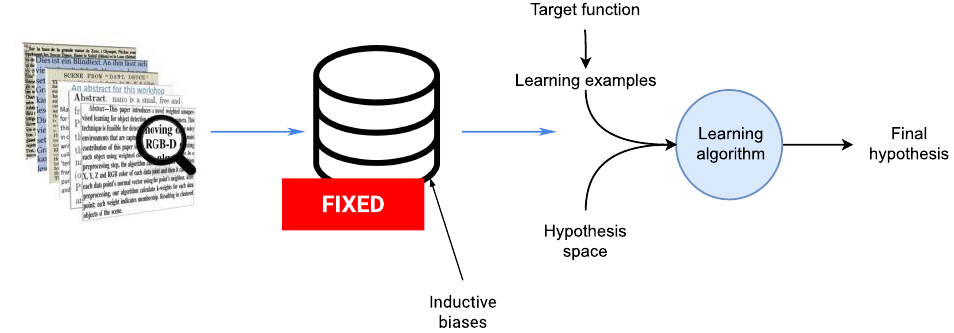
Figure 8. Basic learning setting where the learner is supplied with a fixed set of inductive biases. The inductive biases guide the learner in searching for the hypothesis that explain best the set of learning